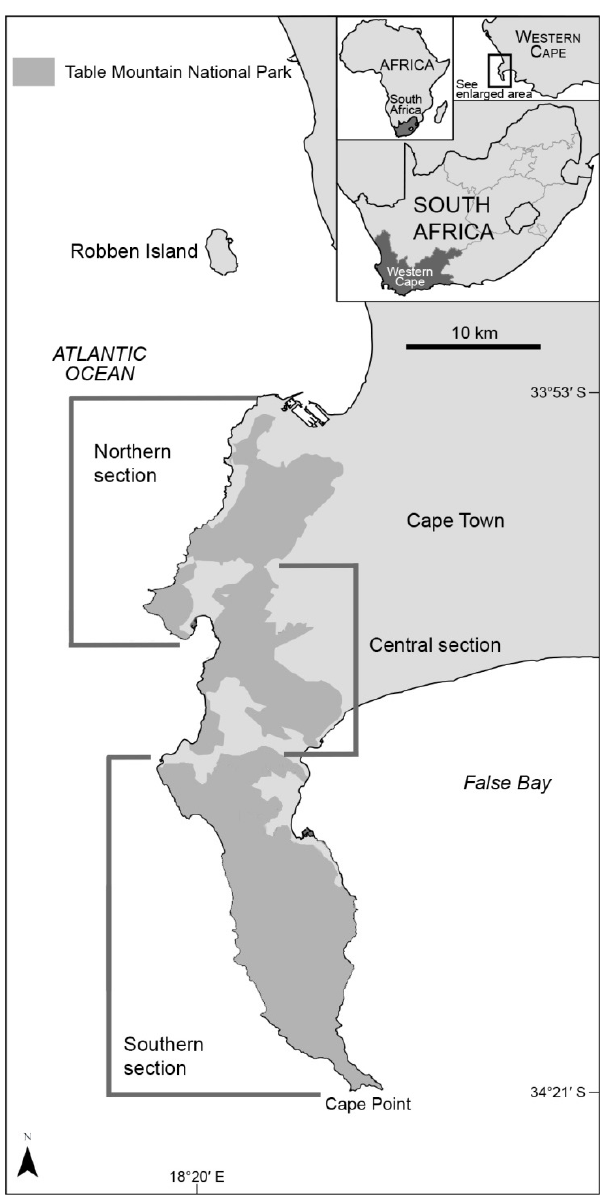
Figure 1. The Table Mountain National Park and its discontinuous sections along the Cape Peninsula, located in the Western Cape province of South Africa.